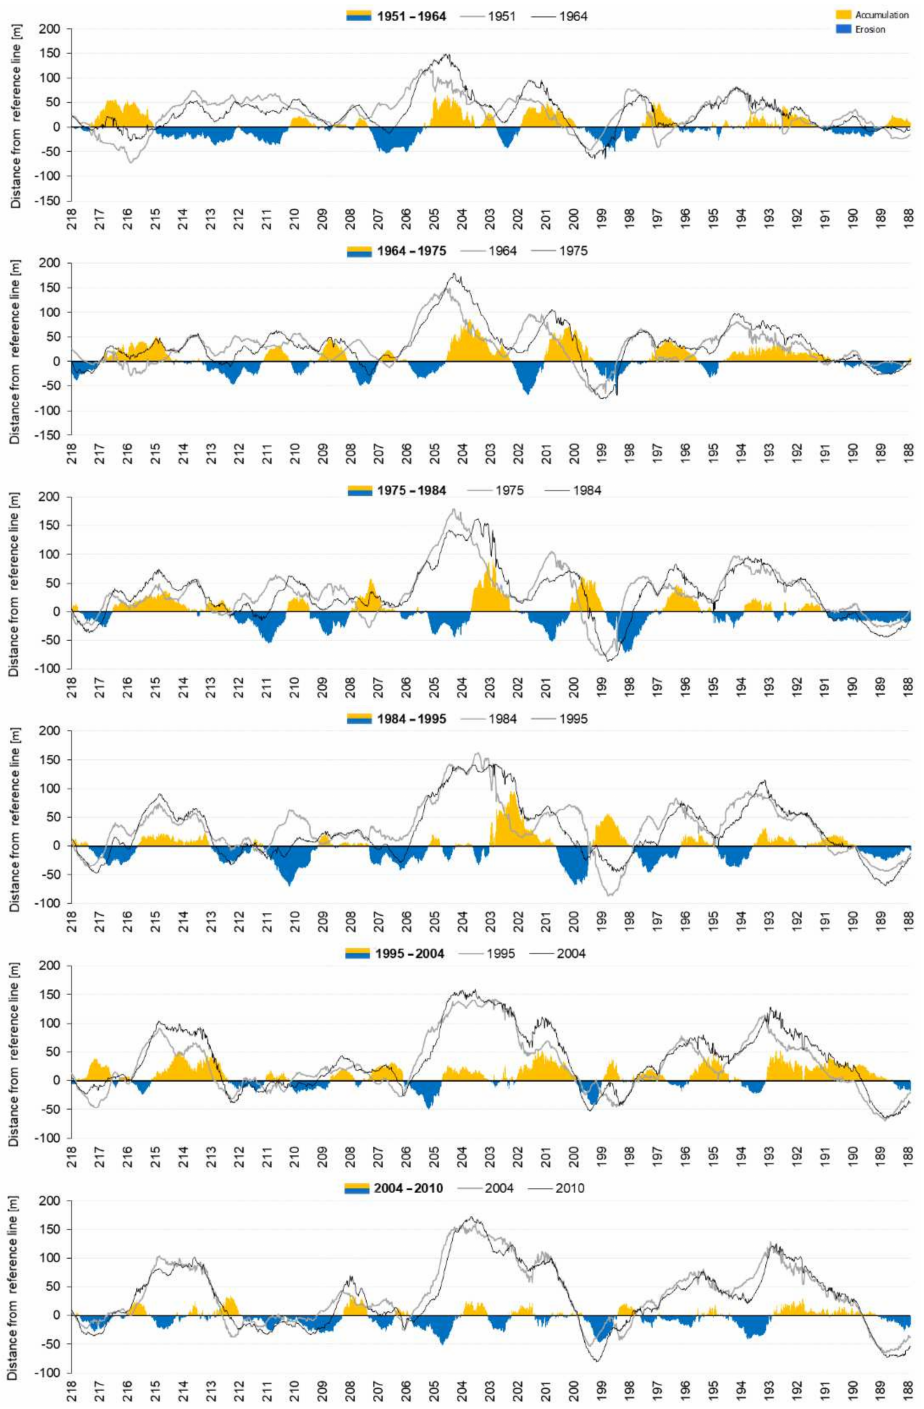
Figure 7. Graphs of the changes in the accumulated and eroded areas in subsequent time intervals (periods close to a decade) on the studied part of the coast (188–218 km according to